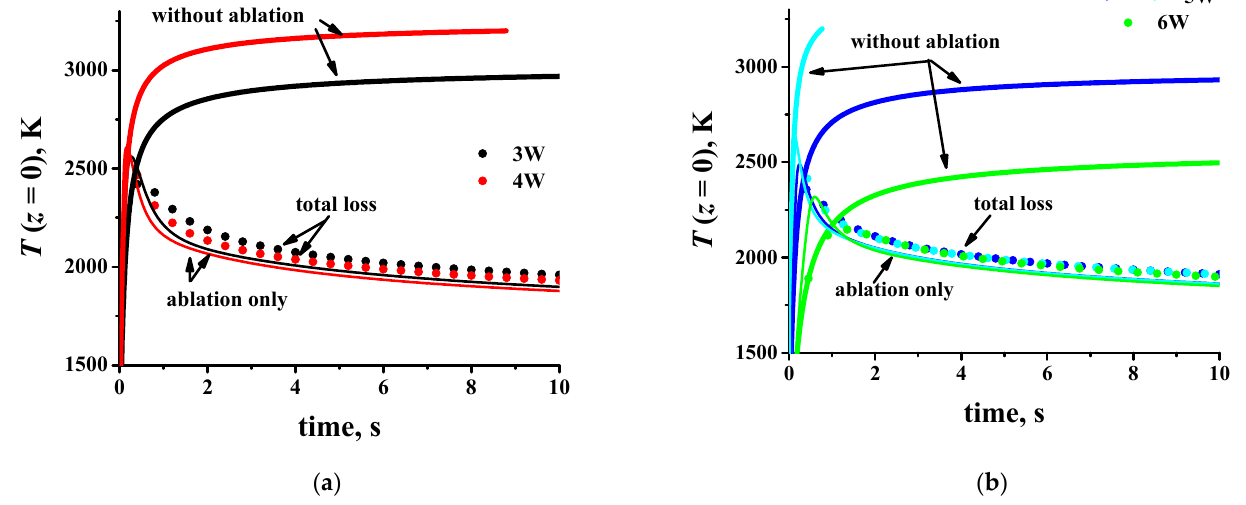
Figure 5 . The change in SAC temperature calculated using the model under the following approximations: Points—all types of losses are taken into account; thin curves—only ablation losses are taken into account; thick curves—only losses due to radiation and heat exchange with the environment are taken into consideration. The laser powers are ( a ) 3 W (black) and 4 W (red), and ( b ) 5 W (blue and cyan) and 6 W (green).